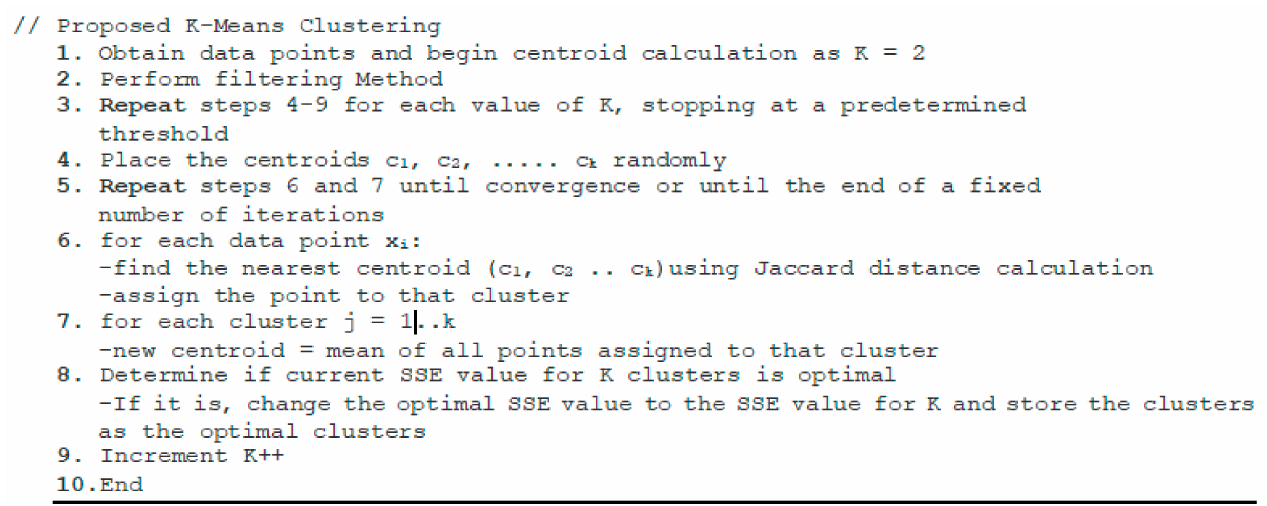
Figure 6. Pseudo code for the proposed K-means clustering with Optimal K search and Filtration Process. The major difference between this method and a standard k-means algorithm is which distance formula is used. The fixed number of iterations refers to the maximum number of times the centroids can be changed while the points are still shifting between clusters. The clusters typically reach the convergence threshold (are correctly grouped) before reaching the max number of